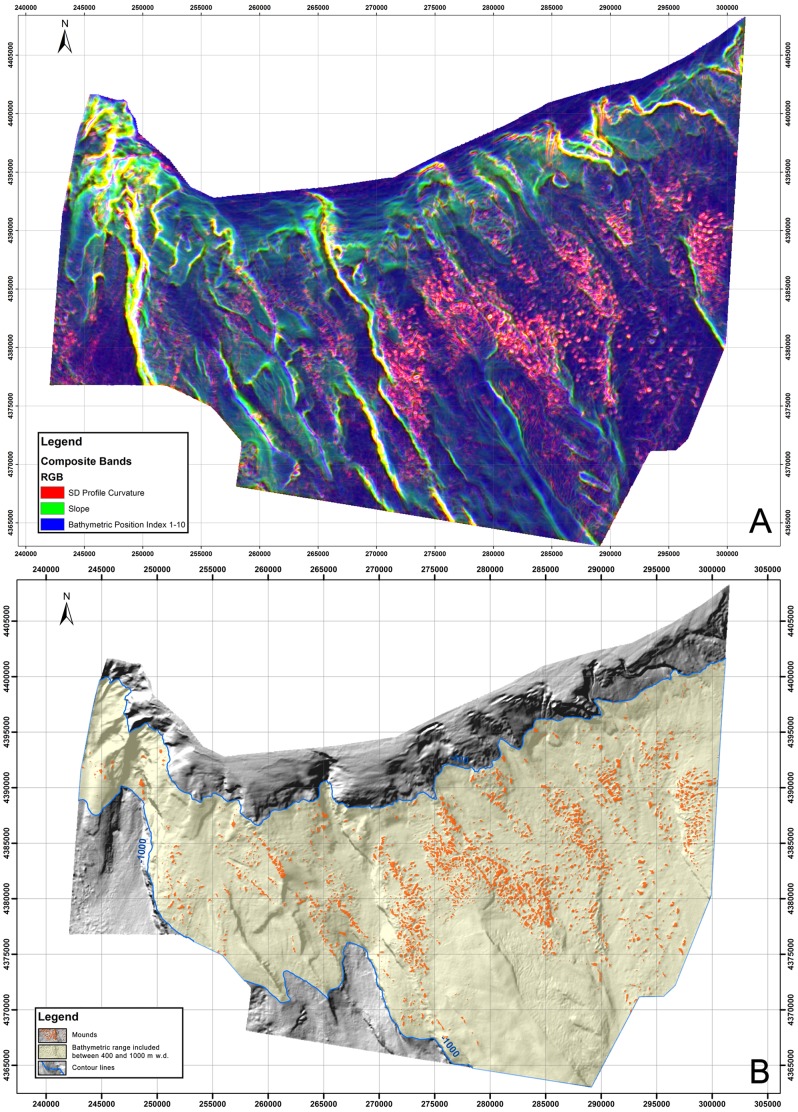
A: A RGB color composite image made by the following TMAs of the study DTM: the SD profile curvature (Red), the slope (Green), and the bathymetric position index 1–10 (Blue). B: The location of all of the extracted polygons that represent coral-mounds (in orange) on the study DTM. Light yellow areas highlight the sector included between 400 and 1000 m of w.d.